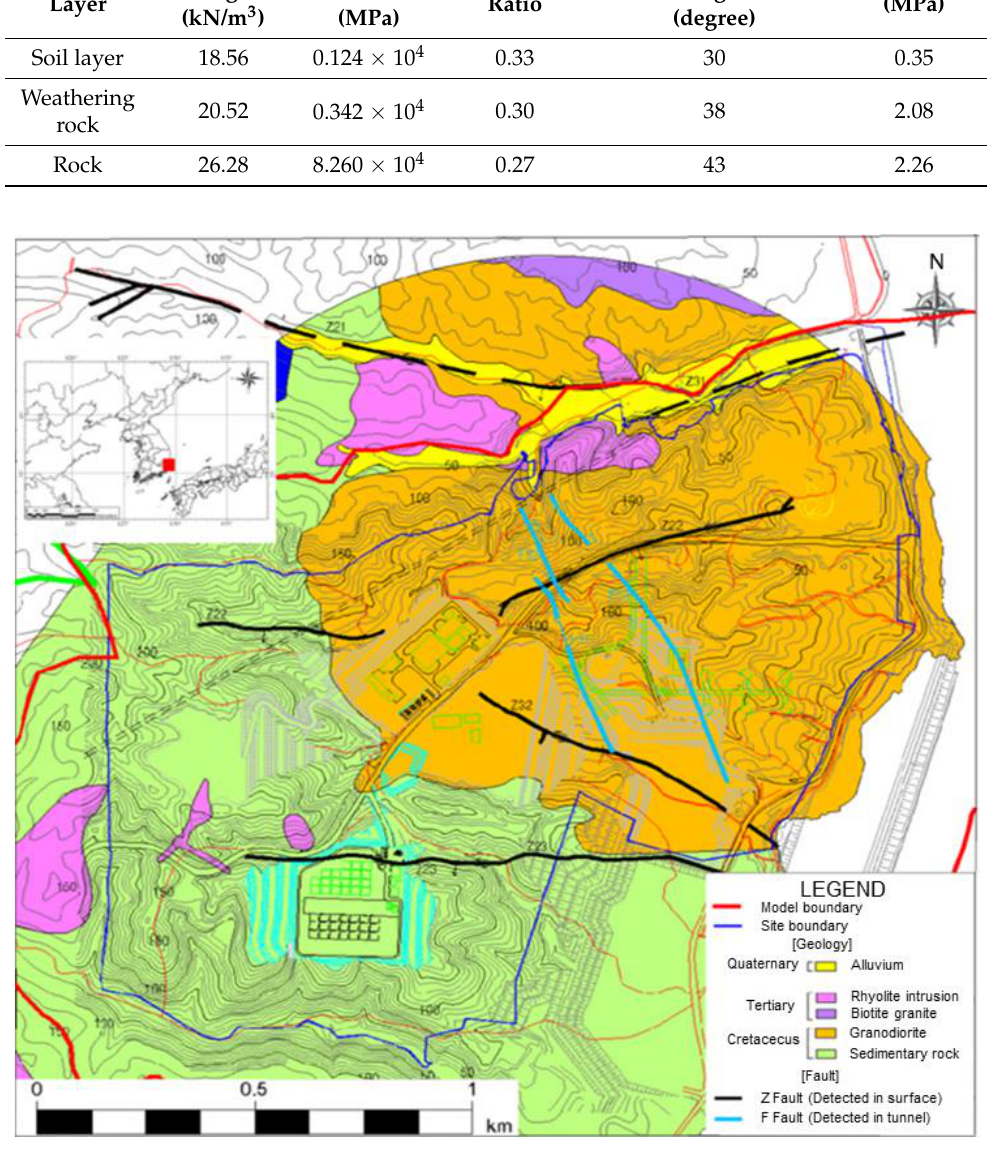
Figure 5. Geological map of the Wolsong site.